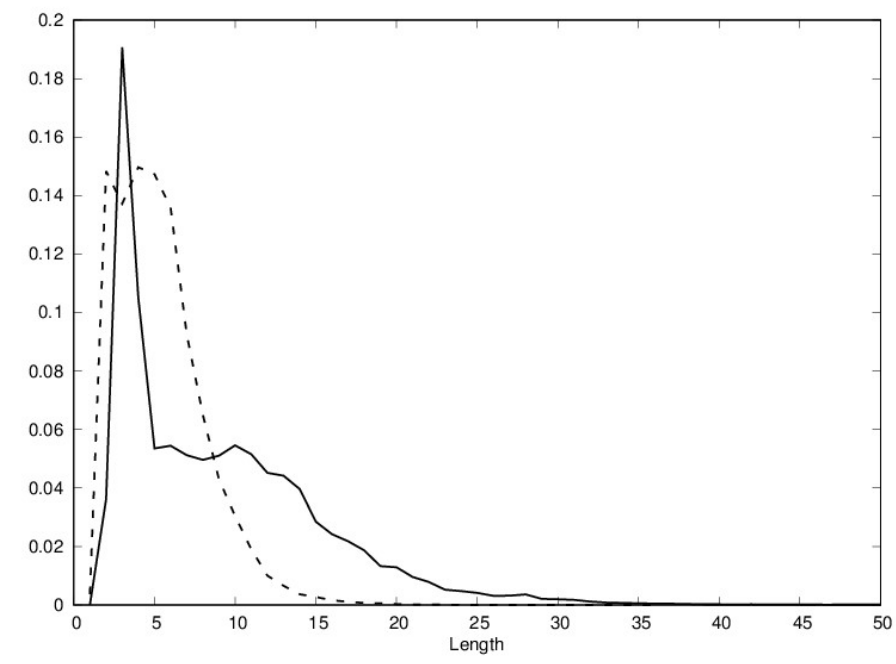
Figure 1. Distribution of helix length (full line) and sheet (broken line) length in the Protein Data Bank (PDB); length is the number of residues.